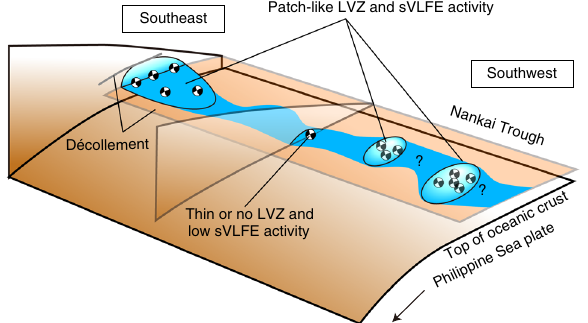
Fig. 4 Schematic for scattered LVZs in Nankai accretionary prism toe. The LVZs are sparsely distributed in the prism toe and the shear strength of faults inside the LVZs is weakened by the presence of fl uid. The occurrence of sVLFEs may be promoted in the LVZ. Gray line 18 and plane 17 indicate two interpretation of the décollement location according to previous southeast and southwest of the Kii Peninsula indicates the presence of a thick LVZ ( > 1 km).